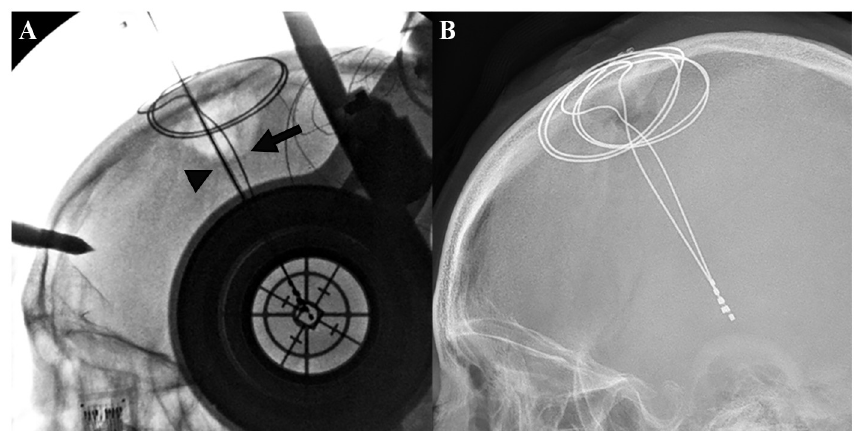
Fig 5. Timing of bending occurrence. A. When the implanted lead is still secured in the guide tube, the lead is straight (arrowhead). In contrast, another lead which is permanently implanted and secured by the burr hole cover is already bent (arrow). B. Immediate postoperative lateral skull X-ray of the identical patient shows that both leads are bent.